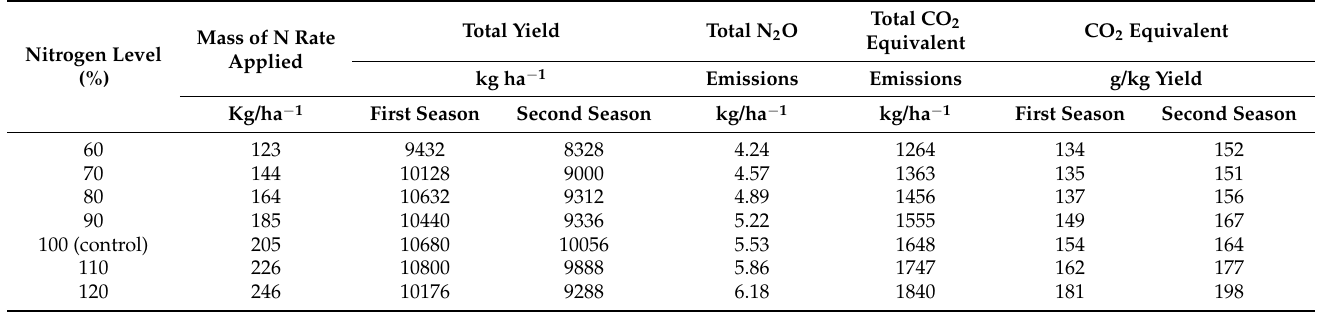
Table 7. Greenhouse gas emissions (CO 2 equivalent) from nitrogen fertilization as affected by total yield per